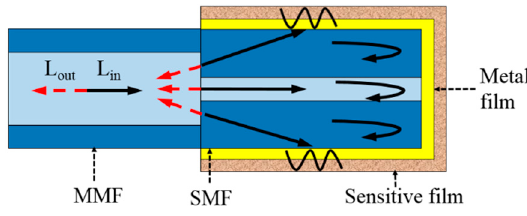
Figure 1. Schematic diagram of the sensing principles.